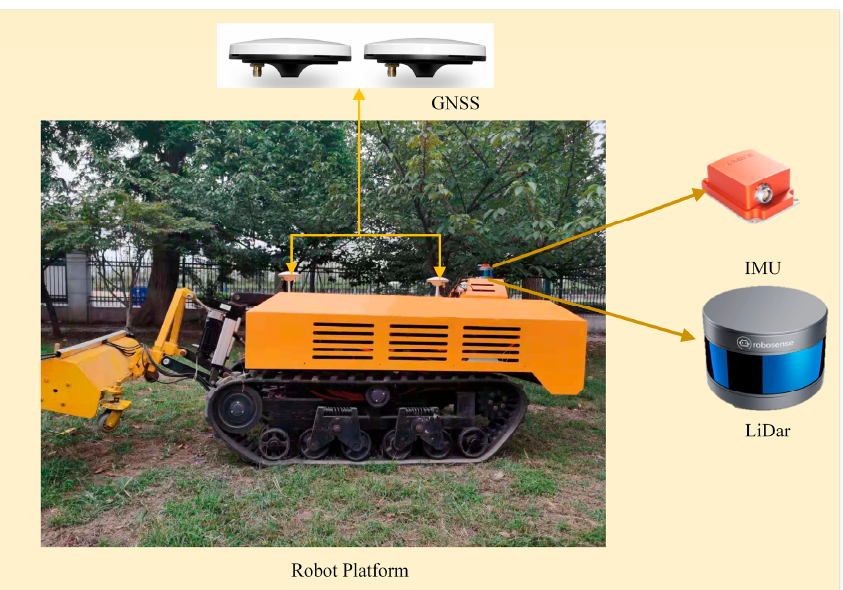
Figure 1. Tracked robot experimental platform and main sensors.